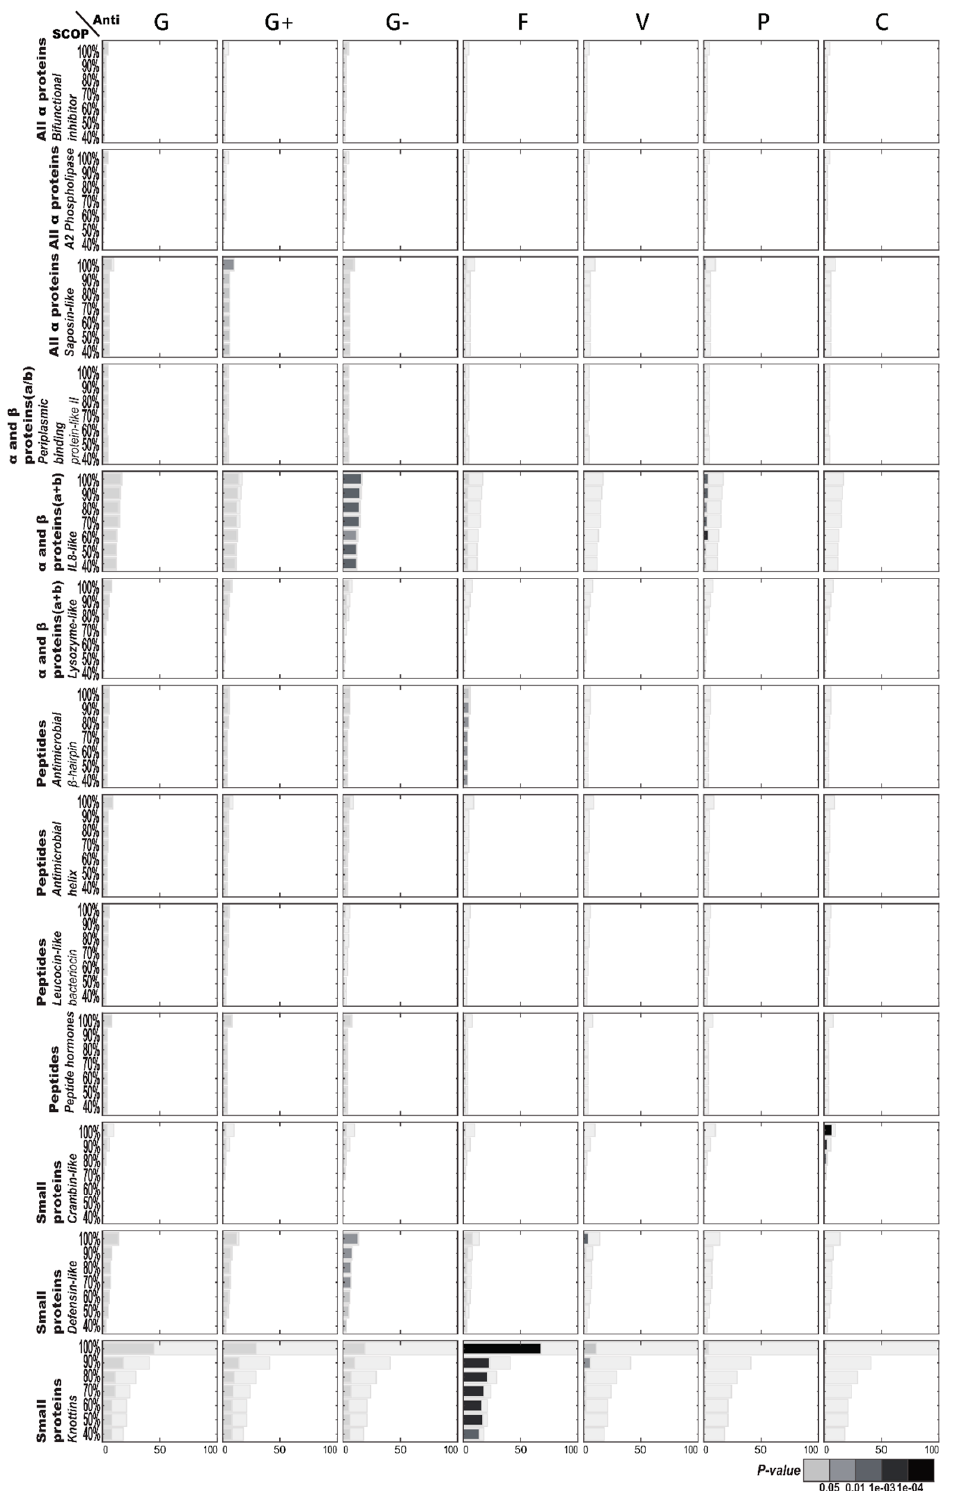
Figure 2. Antimicrobial peptide (AMP) functional enrichment analysis with respect to SCOP structures. The X -axis and Y -axis are, respectively, the number of AMP sequences and the percentage of sequence identity. The bar in light gray indicates the potential maximum number of AMP sequences with the specific function. Abbreviations: C, anticancer; F, antifungal; G, antibacterial; G+, anti-Gram+; G-, anti-Gram-; P, antiparasitic; V, antiviral.